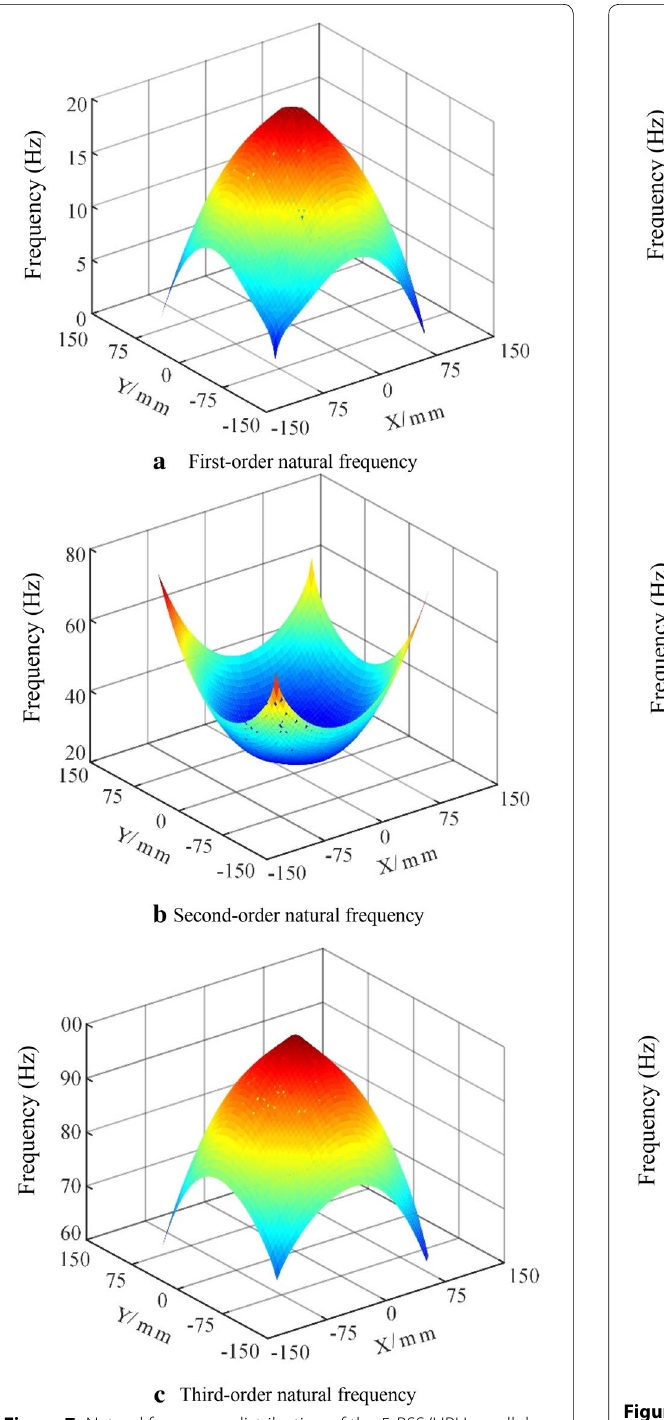
Figure 7 Natural frequency distribution of the 5-PSS/UPU parallel mechanism positional space